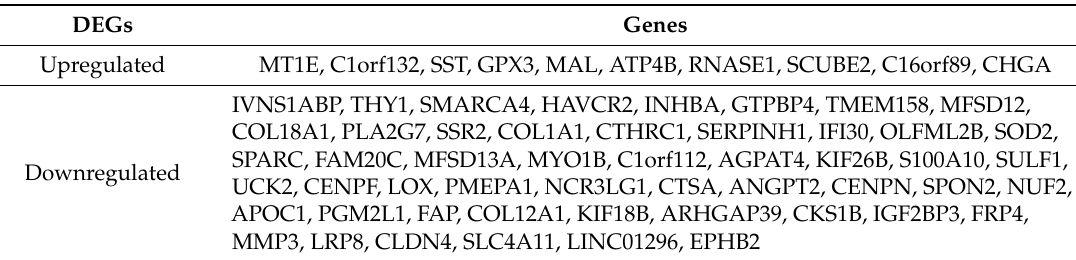
Figure 7. Venn diagrams representing the overlaps between GSE33651 and GSE103236 datasets. ( A ) Venn diagrams illustrating the overlap of downregulated genes. ( B ) Venn diagrams illustrating the overlap of upregulated genes. Table 4. Screening DEGs in gastric